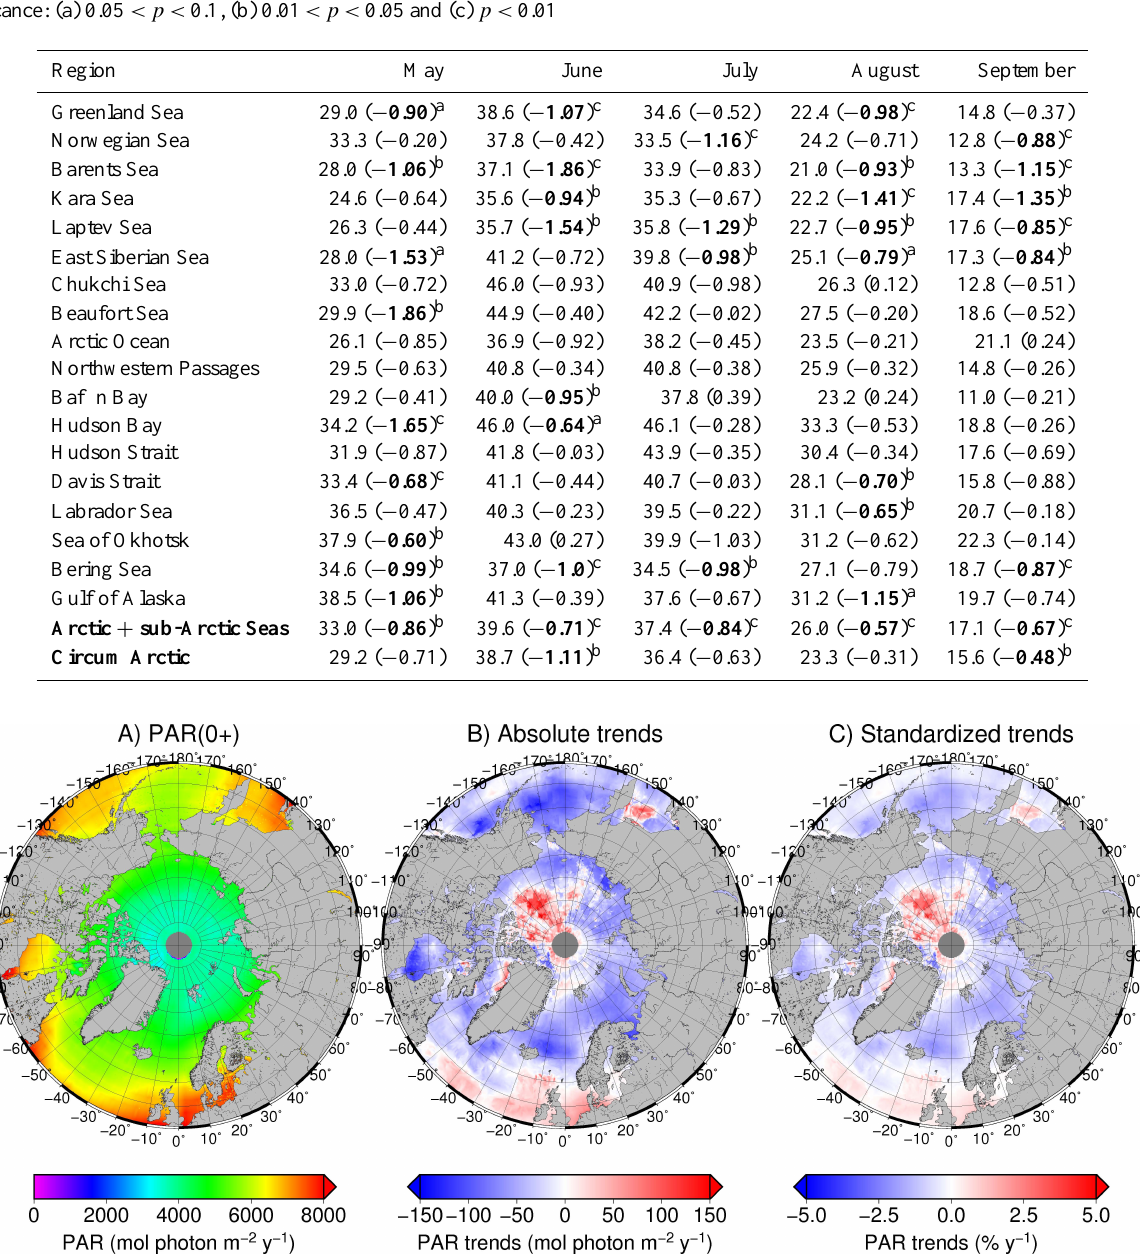
calculated using CHL from OC4 and K d from W05, the to- tal PP rises by ∼ 85 % to reach 357 ± 15 TgCyr − 1 , which is still lower than previous estimation of Arrigo et al.